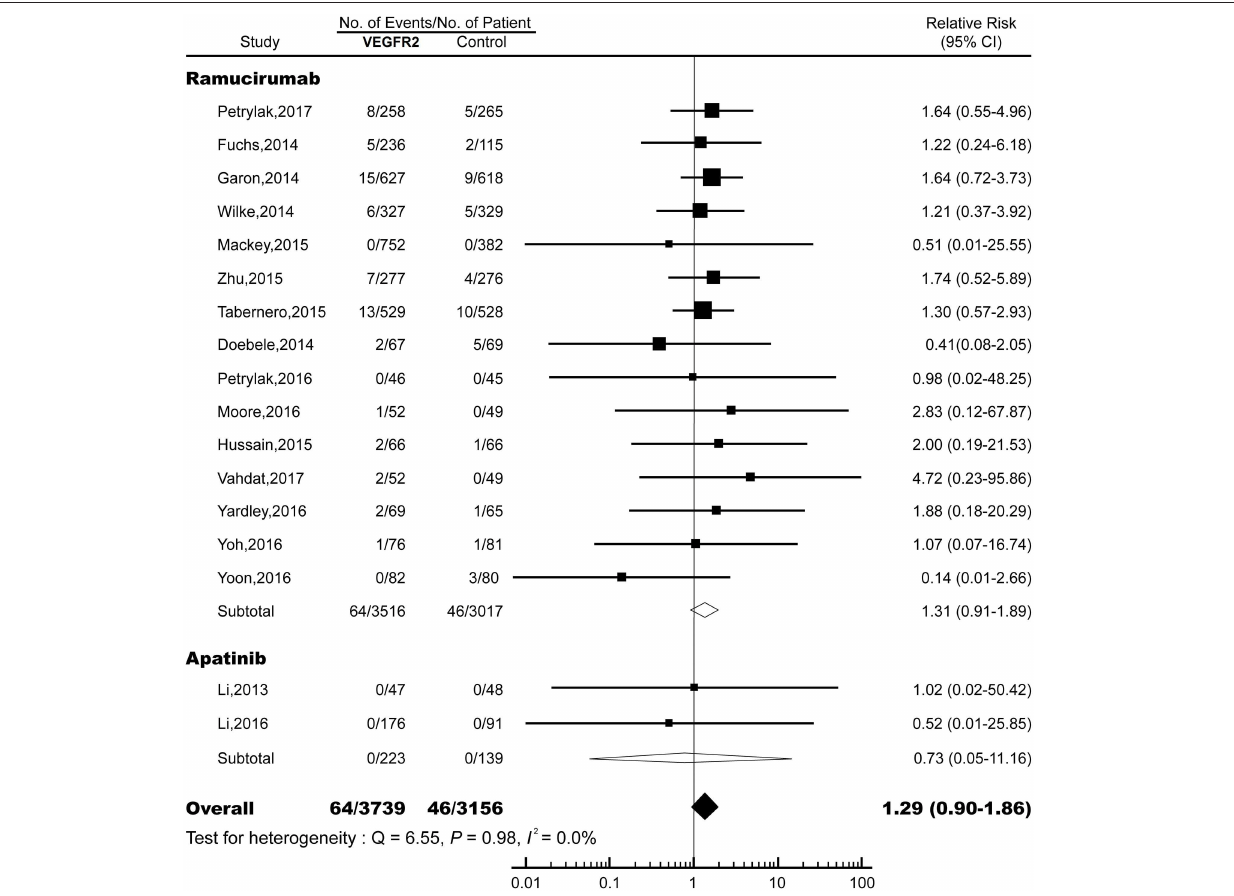
Frontiers in Medicine |